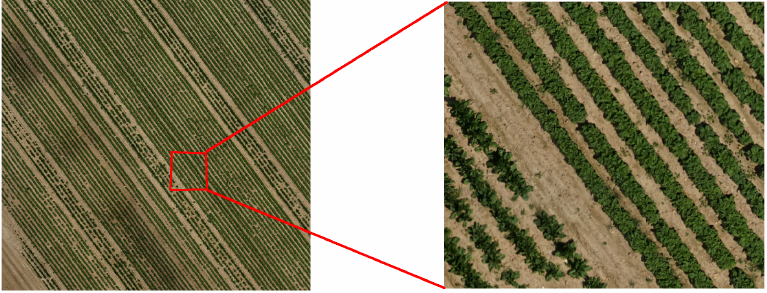
Figure 3. Example of image captured from a spinach study